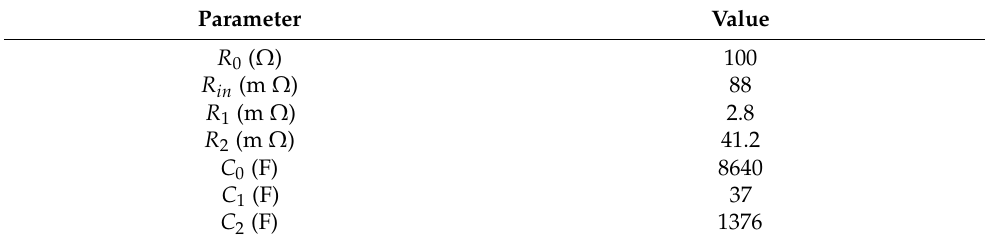
Table 2. Battery cell #1 model